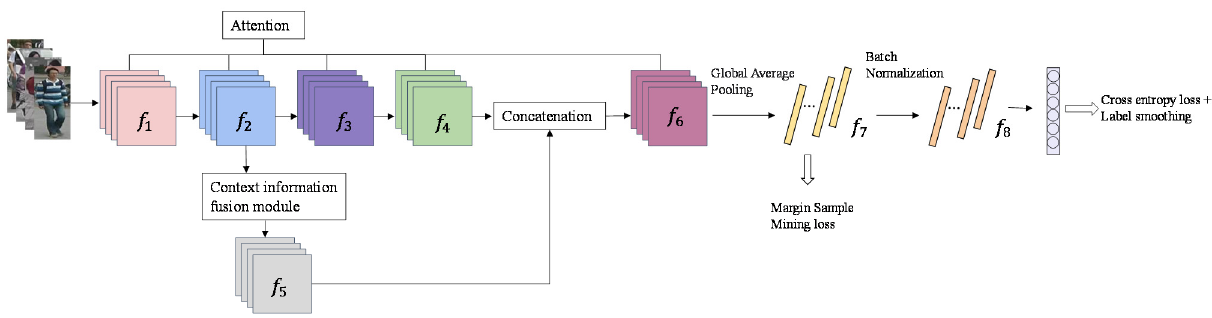
Figure 1. Overall framework of the person re-identificaton (ReID) model we propose. The channel attention module is introduced into the ResNet50. Feature map f 5 is generated by context information fusion module, and it is cascaded with feature map f 4 . Feature map f 8 is used for the inference stage.